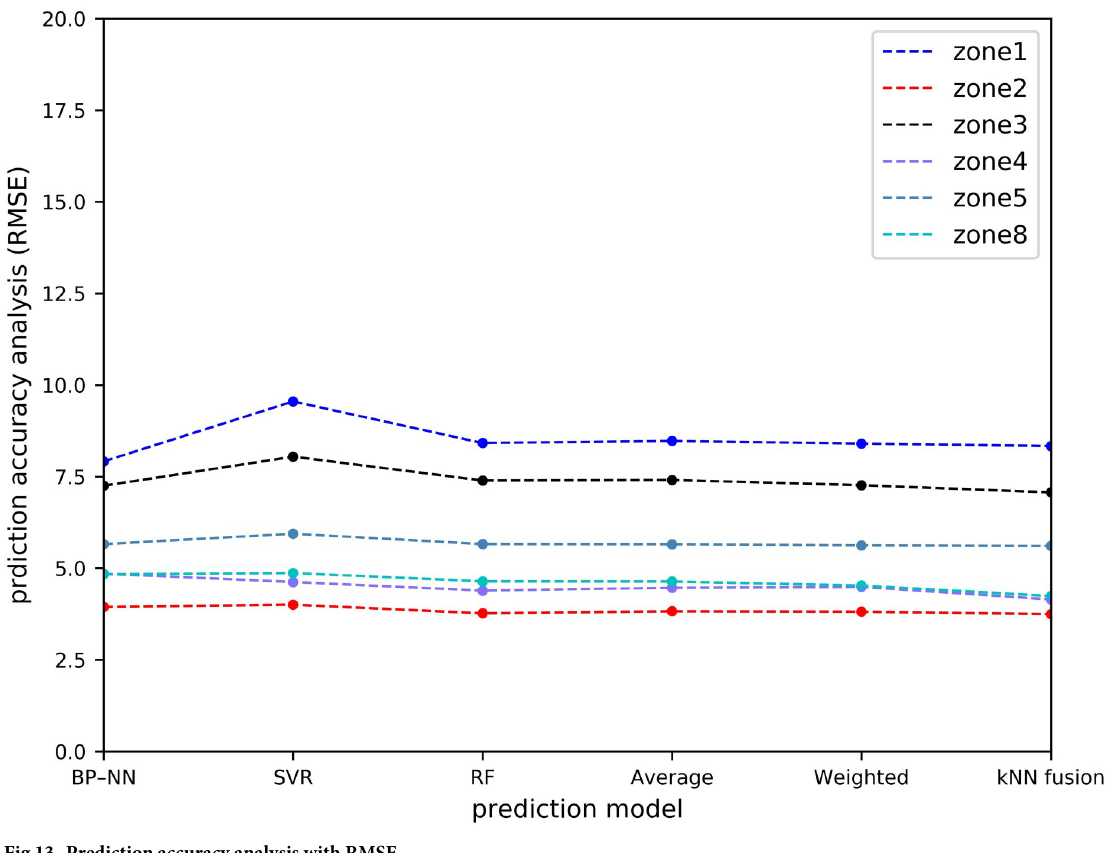
Fig 13. Prediction accuracy analysis with